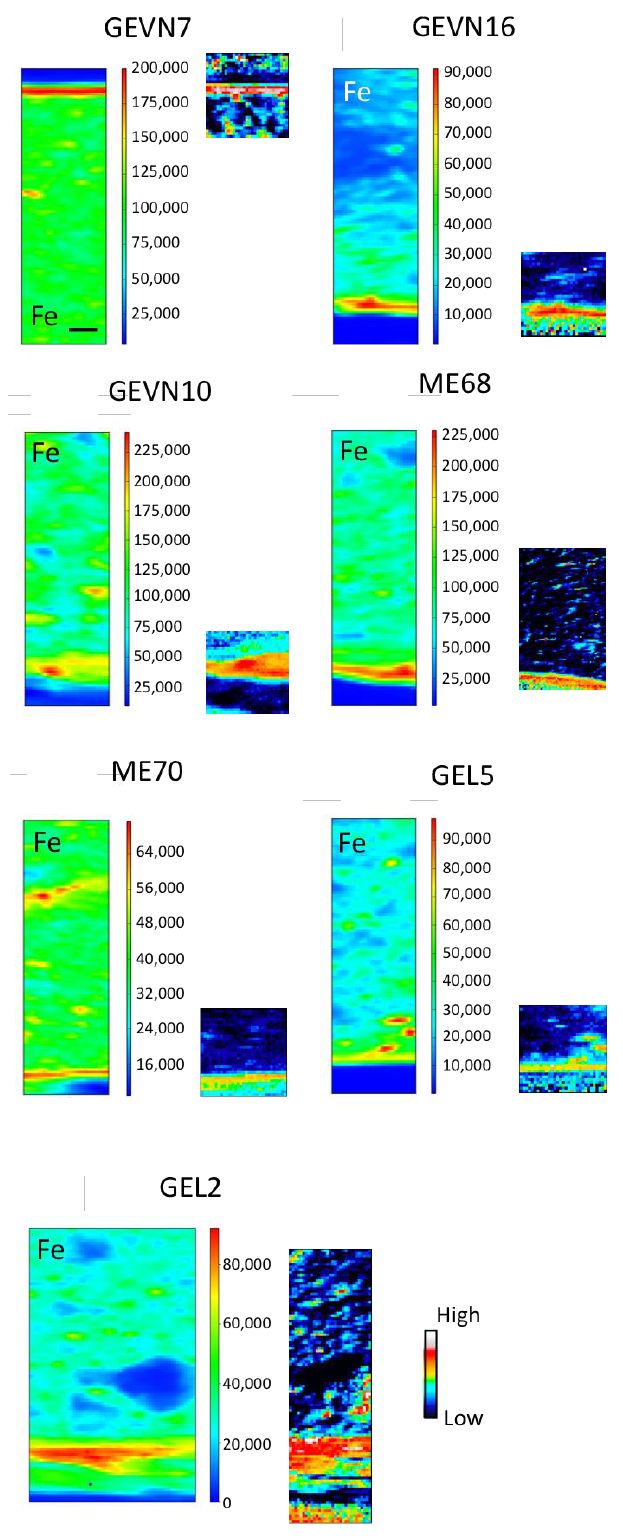
Figure 3. Fe XRF maps of sample GEVN7, GEVN10, GEVN16, ME68, ME70, GEL2 and GEL5 in cross section geometry, together with the corresponding distribution of the ratio between the maps collected at 7127 eV and 7132 eV. Scale bar is 50 µm and is valid for all images.